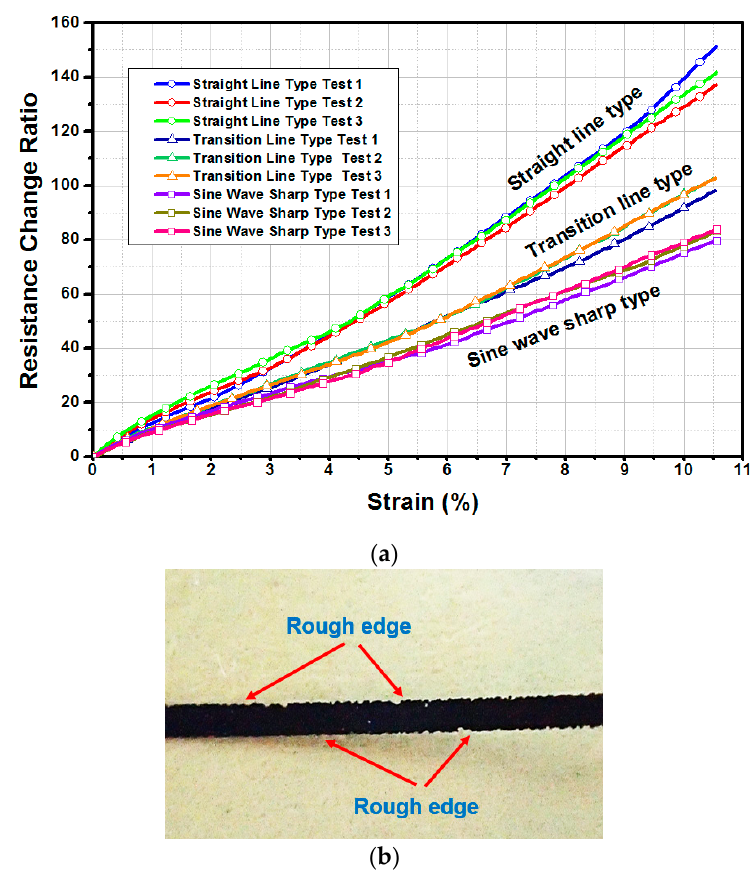
Figure 12. Comparison of electrical resistance variations for three different interconnect geometry designs after stretchable loading: ( a ) test results; ( b ) occurrence of rough edges for straight line type interconnect.